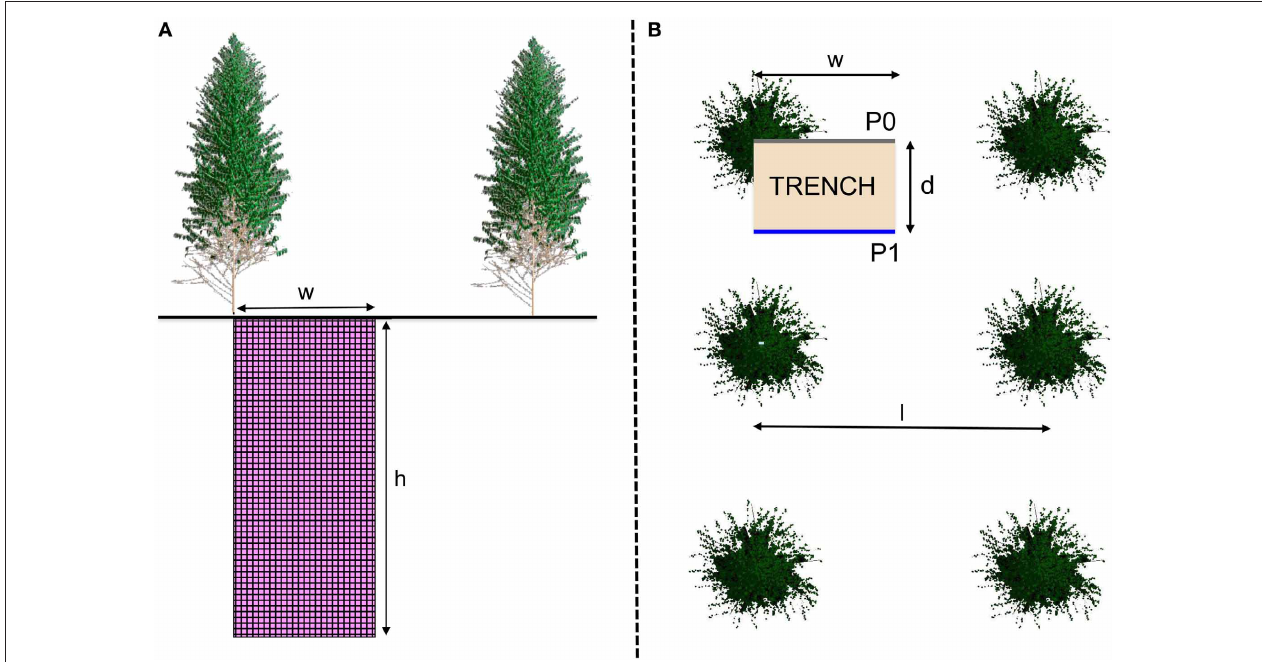
FIGURE 1 | Layout of soil profiles P0 (from the bottom of a trunk to the middle of the inter-row) and P1 (from midway between 2 trees in the planting row to the middle of the inter-row) in each stand showed in a side (A) and top view (B). The distance between rows ( I ) was 300cm and the distance between trees in the planting row (2 d ) was 200cm, in the